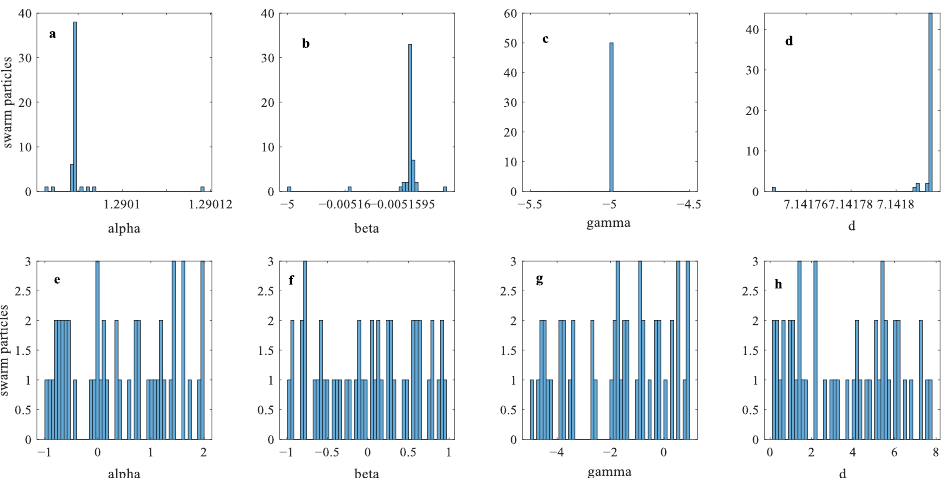
Figure 11. Swarm distribution before the randomness operator ( a – d ) and after the application of the randomness operator ( e – h